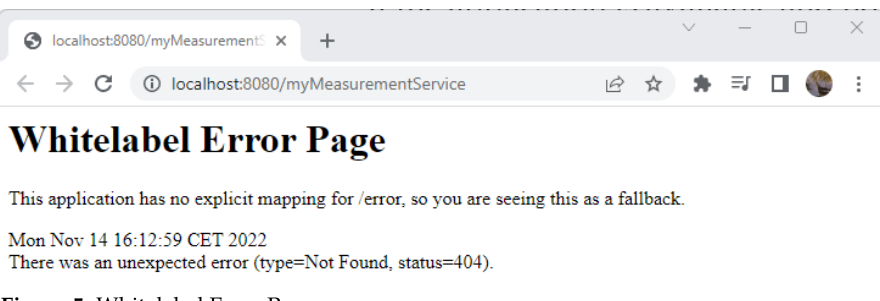
Figure 5. Whitelabel Error Page.